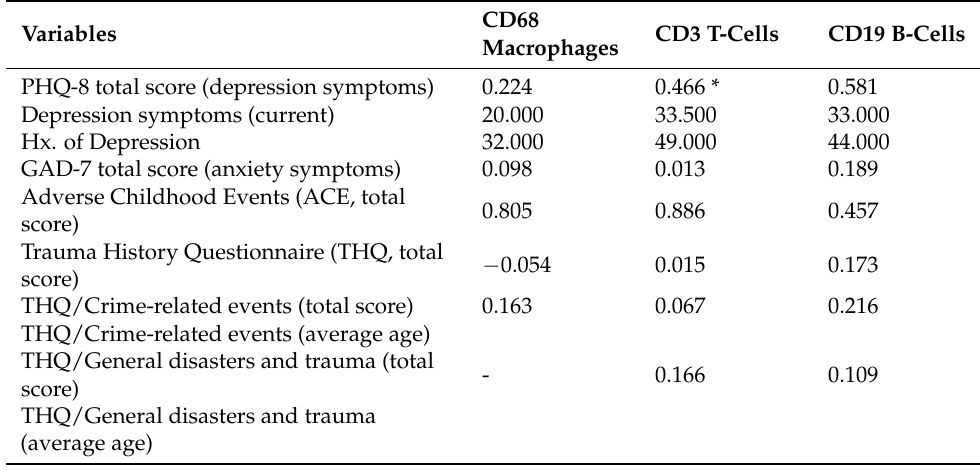
Table 3. Correlations among depression, anxiety, exposure to SEA, and immune cell